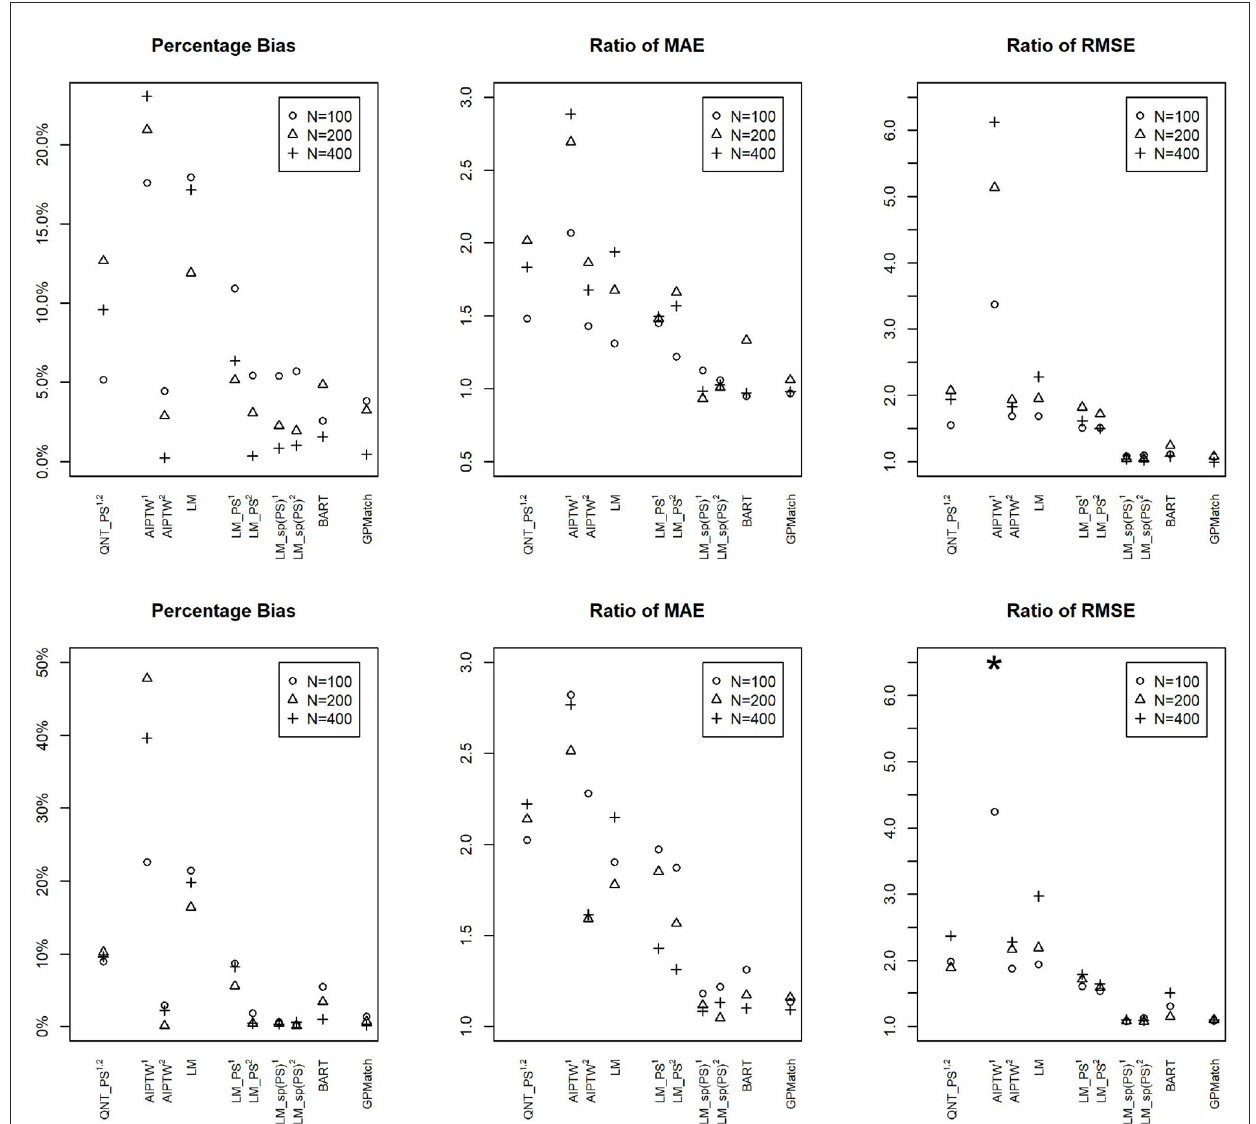
FIGURE2 Comparisons of percentage bias, root mean square error (RMSE), and median absolute error (MAE) of the ATE Estimates by Different Methods Across Different Sample Sizes under the Simulation Setting 1a (upper panel) : U i = 0, U 0 i ∼ N (0,0.25), σ 2 0 = 0.75 and Setting 1b (lower panel) : U i ∼ N (0,0.15 2 ), U 0 i ∼ N (0,1), σ 2 0 = 0. 1 Propensity score estimated using logistic regression on logitA ∼ X . 2 Propensity score estimated using logistic regression on logitA ∼ X 1 / 3 . GPMatch, Bayesian structural model with Gaussian process prior; QNT_PS, Propensity score sub-classification